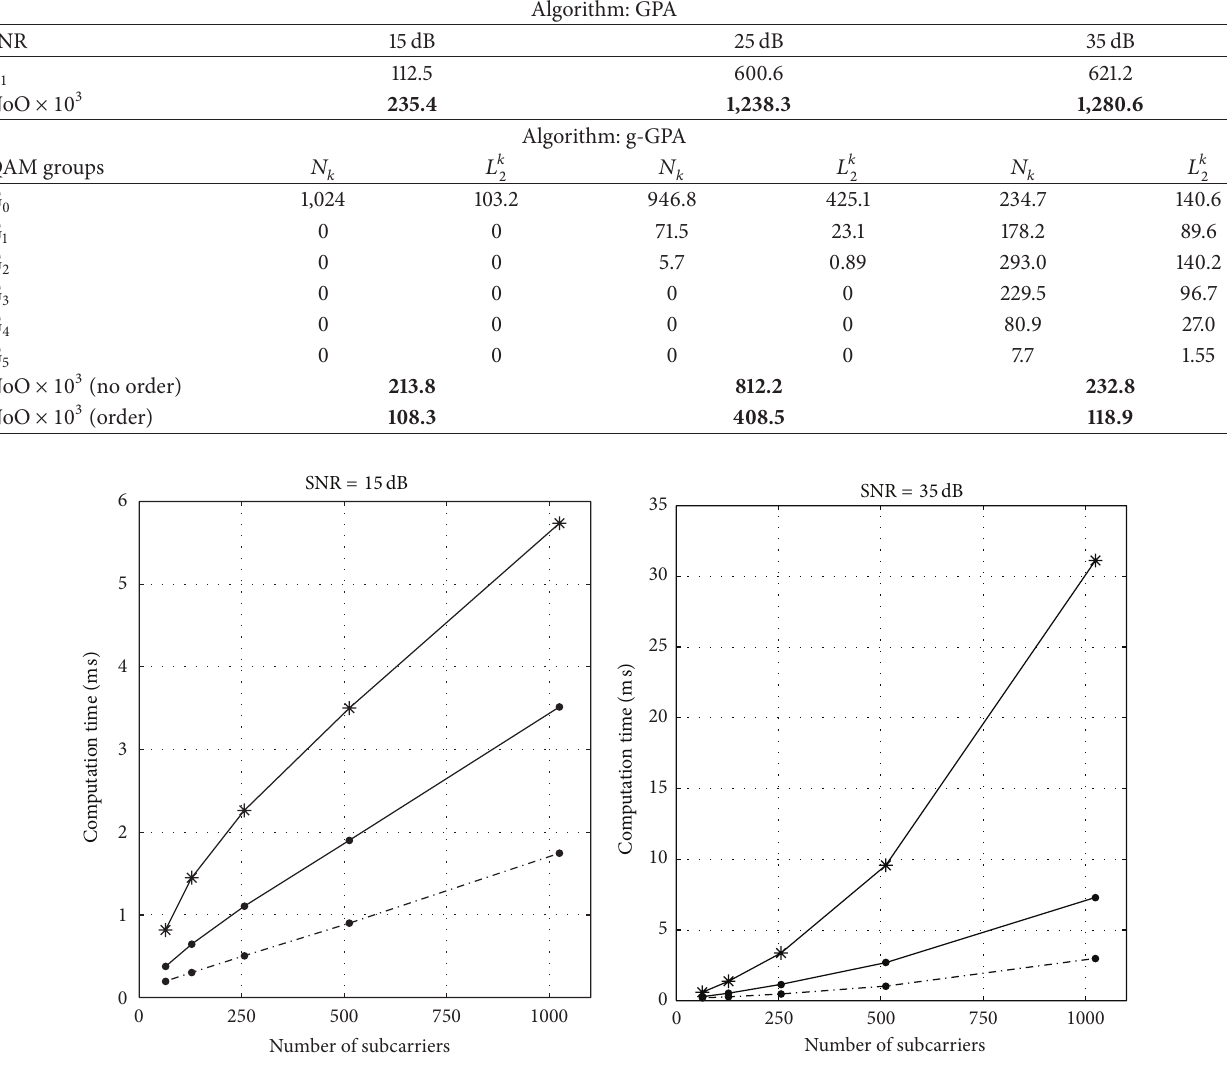
Table 2: Simulation results for the parametric analysis of the GPA and g-GPA algorithms given in Table 1 for a 1024-subcarrier system and different SNR values.